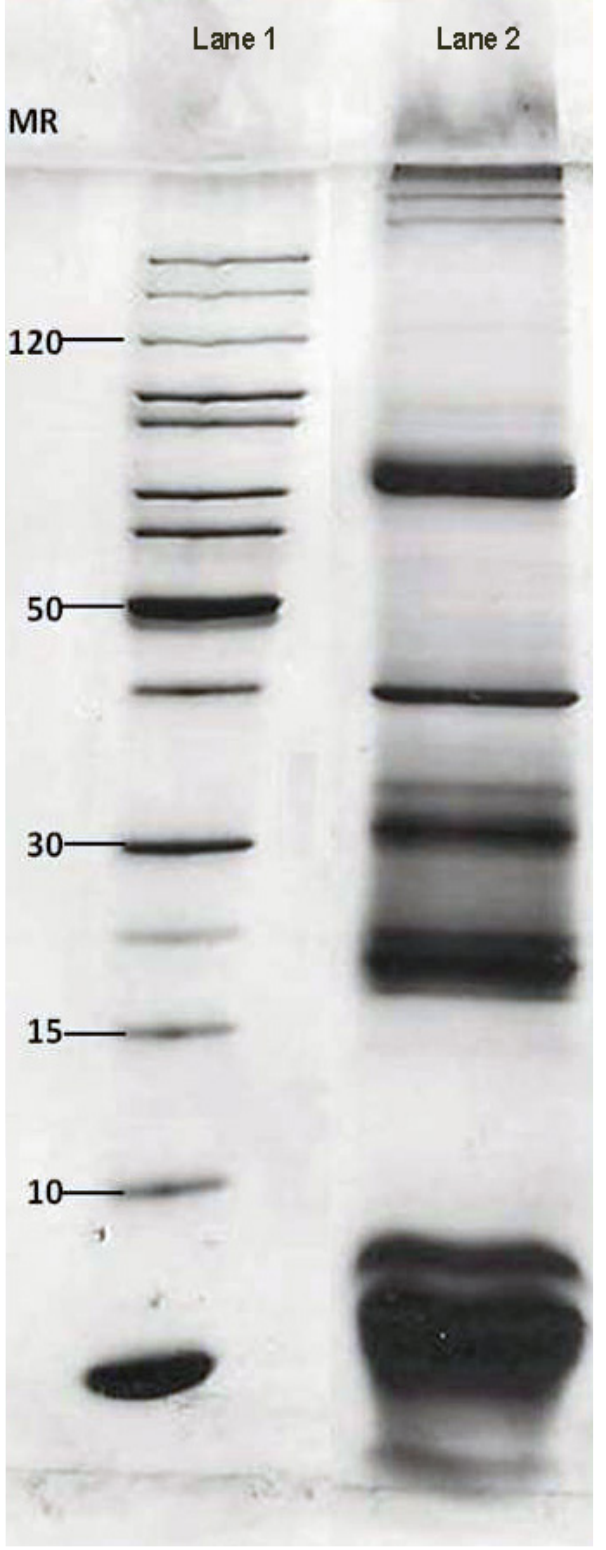
Figure 2. Median lethal dose of Tityus serrulatus venom. The figure represents six different experiments ± standard deviation. Identical letters indicate no significant difference by post test of Tukey (p <